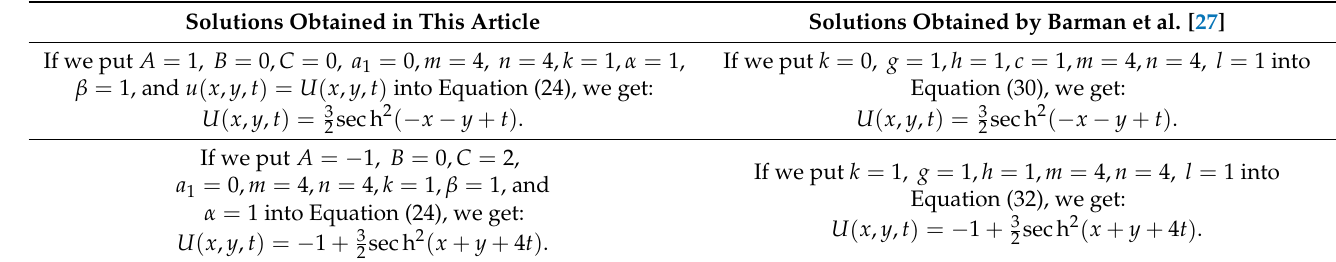
Table 1. Comparison of the achieved results with the results obtained by Barman et al. [27]. Solutions Obtained in This Article Solutions Obtained by Barman et al.